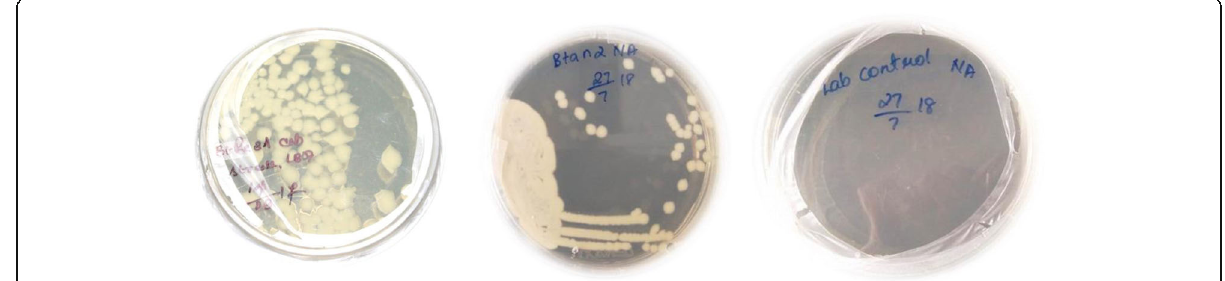
Fig. 2 Putative Bt like colonies isolated from soil samples collected from the Andaman Nicobar Islands. Laboratory control NA plate and Purified Bacillus thuringiensis colony morphology, Bacterial isolate exhibiting the Chalky white with granular periphery a typical Bt